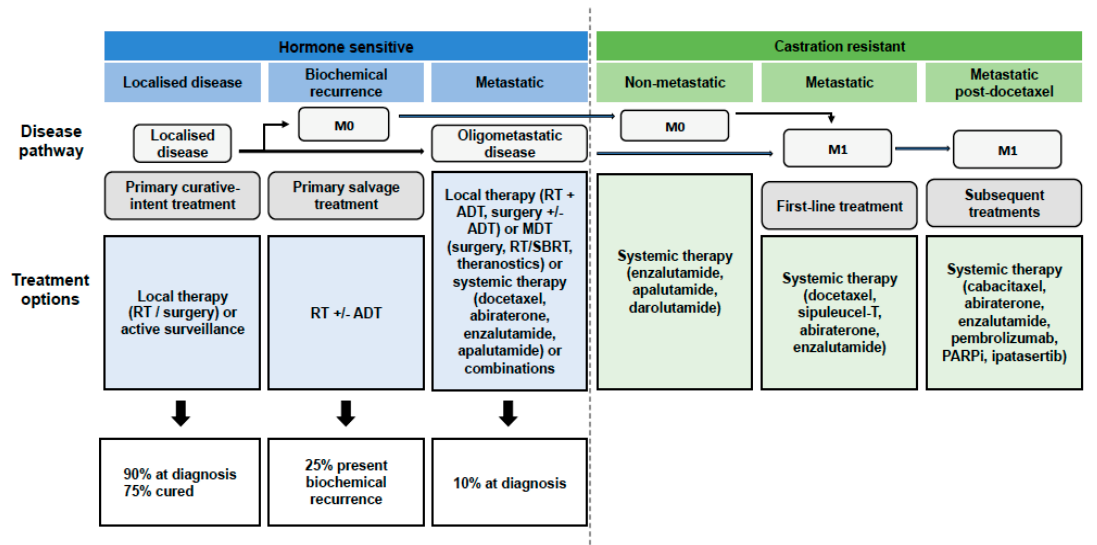
Figure 1. Natural history of oligometastatic prostate cancer. Prostate cancer is split into different clinical states (hormone-sensitive disease shown in blue and castration-resistant disease shown in green) with progressively increasing total tumour burden (represented by the arrows). Below, the different therapeutic options for each of the states are shown. Abbreviations: RT, radiotherapy; M0, non-metastatic disease; ADT, androgen deprivation therapy; MDT, metastasis directed therapy; SBRT, stereotactic body radiotherapy; M1, metastatic disease; PARPi, poly ADP ribose polymerase enzyme